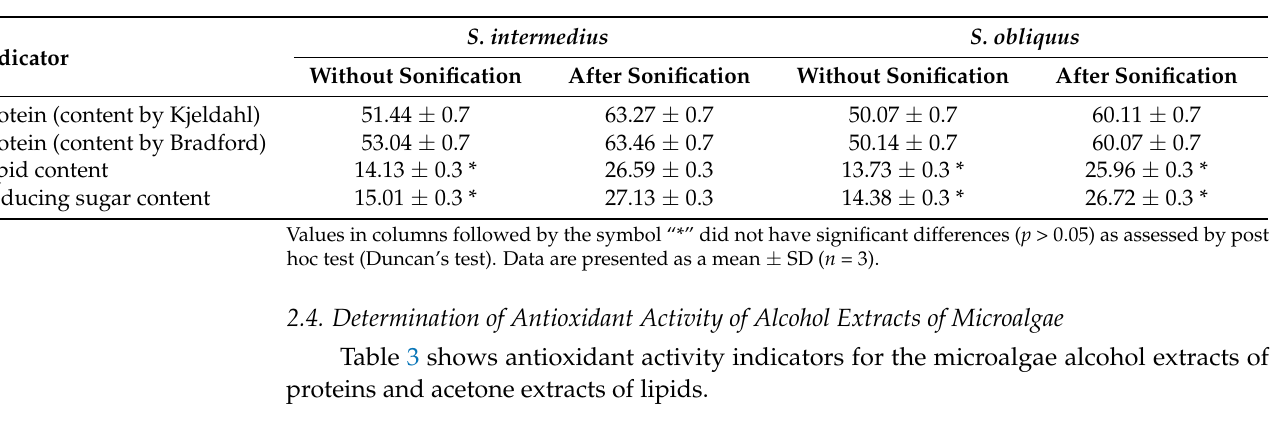
Table 2. Content of proteins, lipids, and reducing sugars in S. intermedius and S. obliquus microalgae samples (Filinskaya Bay, Baltic Sea) without and after